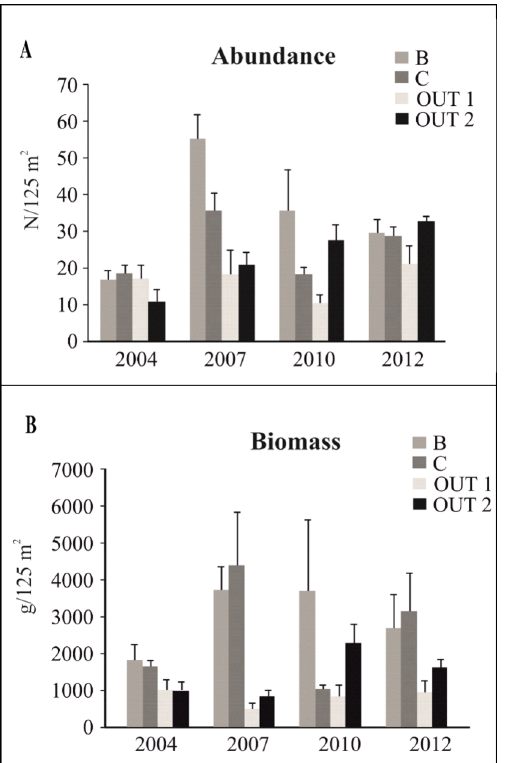
Fig 4. Reserve effect on commercial species. Mean values ( ± SE) of (A) abundance and (B) biomass.